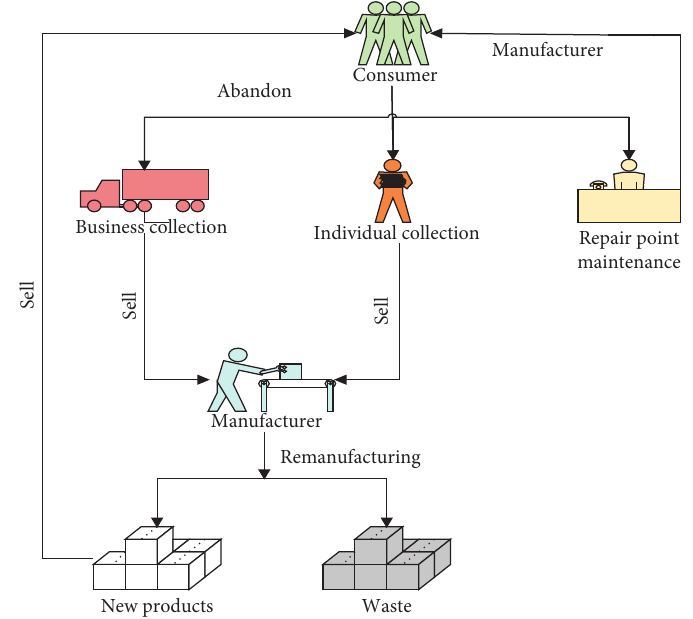
Figure 1: E-waste recycling flow